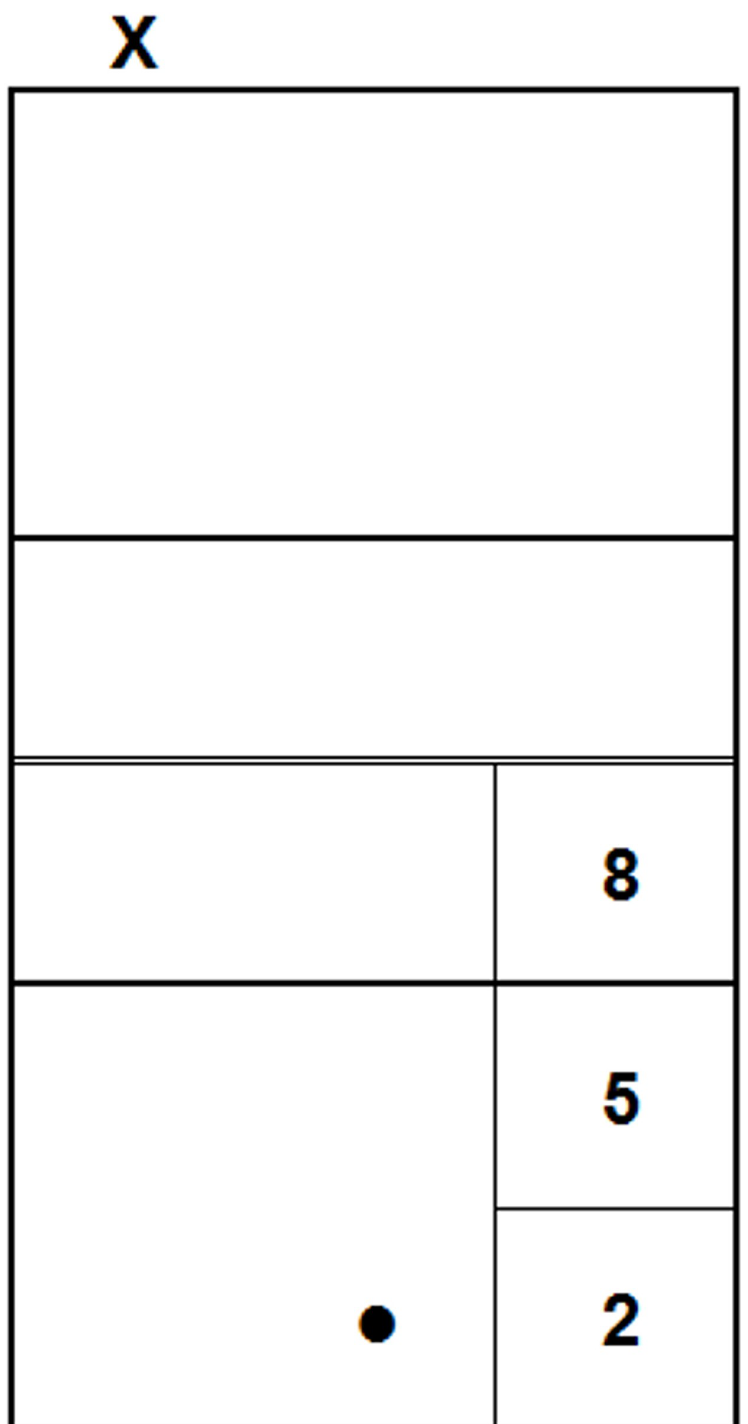
Fig 7. Correspondence between the sectors and the response keys on the keypad. This image was included in the instructions.